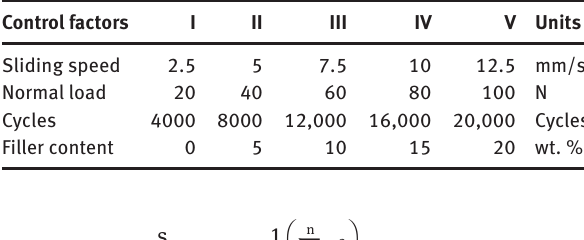
Table 5: Levels of the variables used in the experiment.